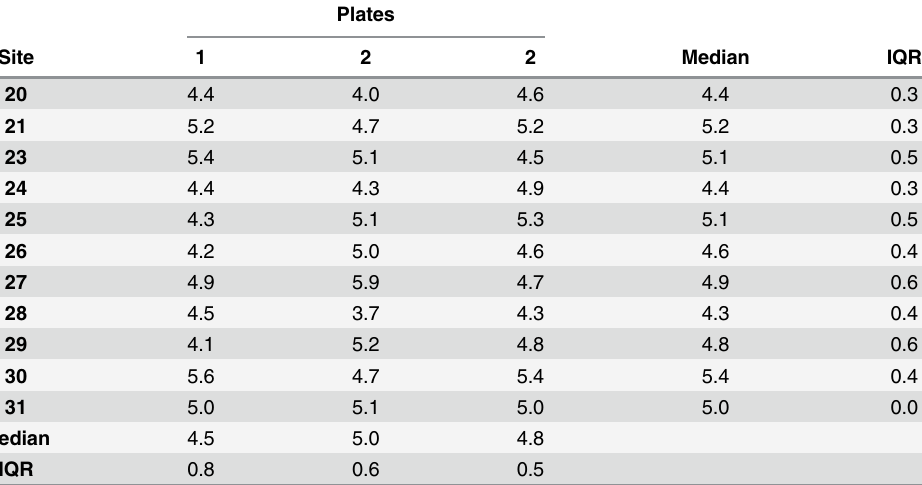
Table 2. Consistency of variant detection for an engineered plasmid mix. A plasmid mix containing a variant present at approximately 5% was sequenced in triplicate at each site. The frequency of the minority variant is given in percent. The replicates were distributed over 3 of the 4 PCR plates.